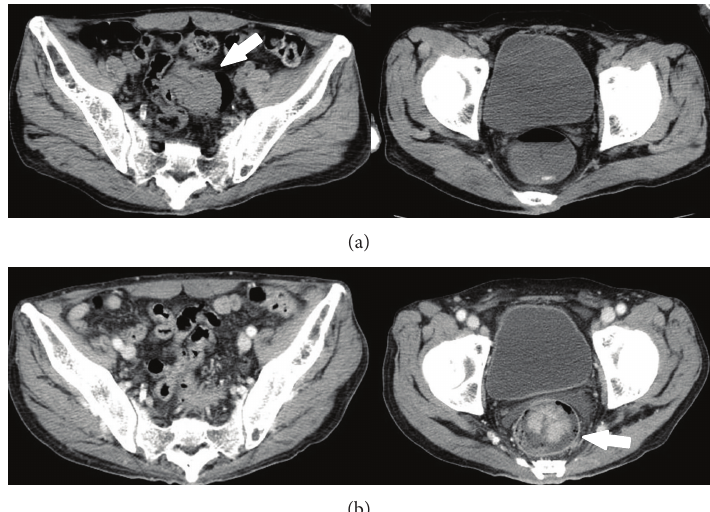
Figure 3: Initial CT showed the tumor located in the rectosigmoid colon (a). Preoperative contrast-enhanced CT showed that the tumor shifted to rectum below the peritoneal reflection (b).